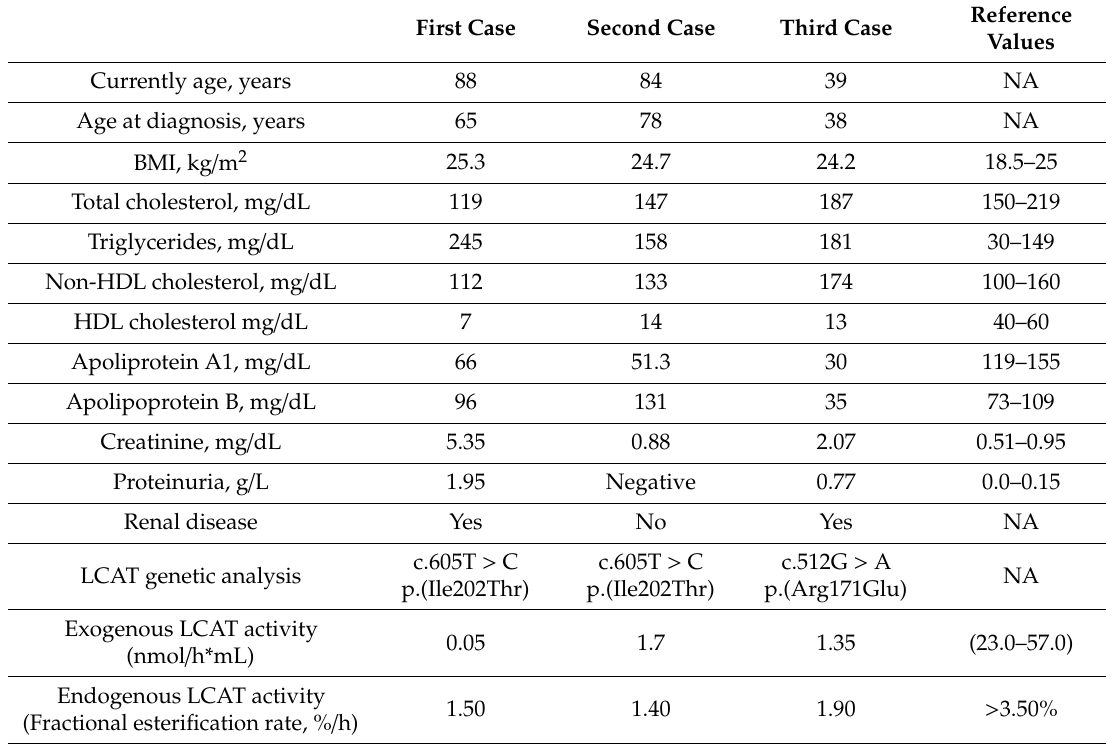
Table 1. Lipid profile and lecithin cholesterol acyltransferase ( LCAT) activity in all cases.